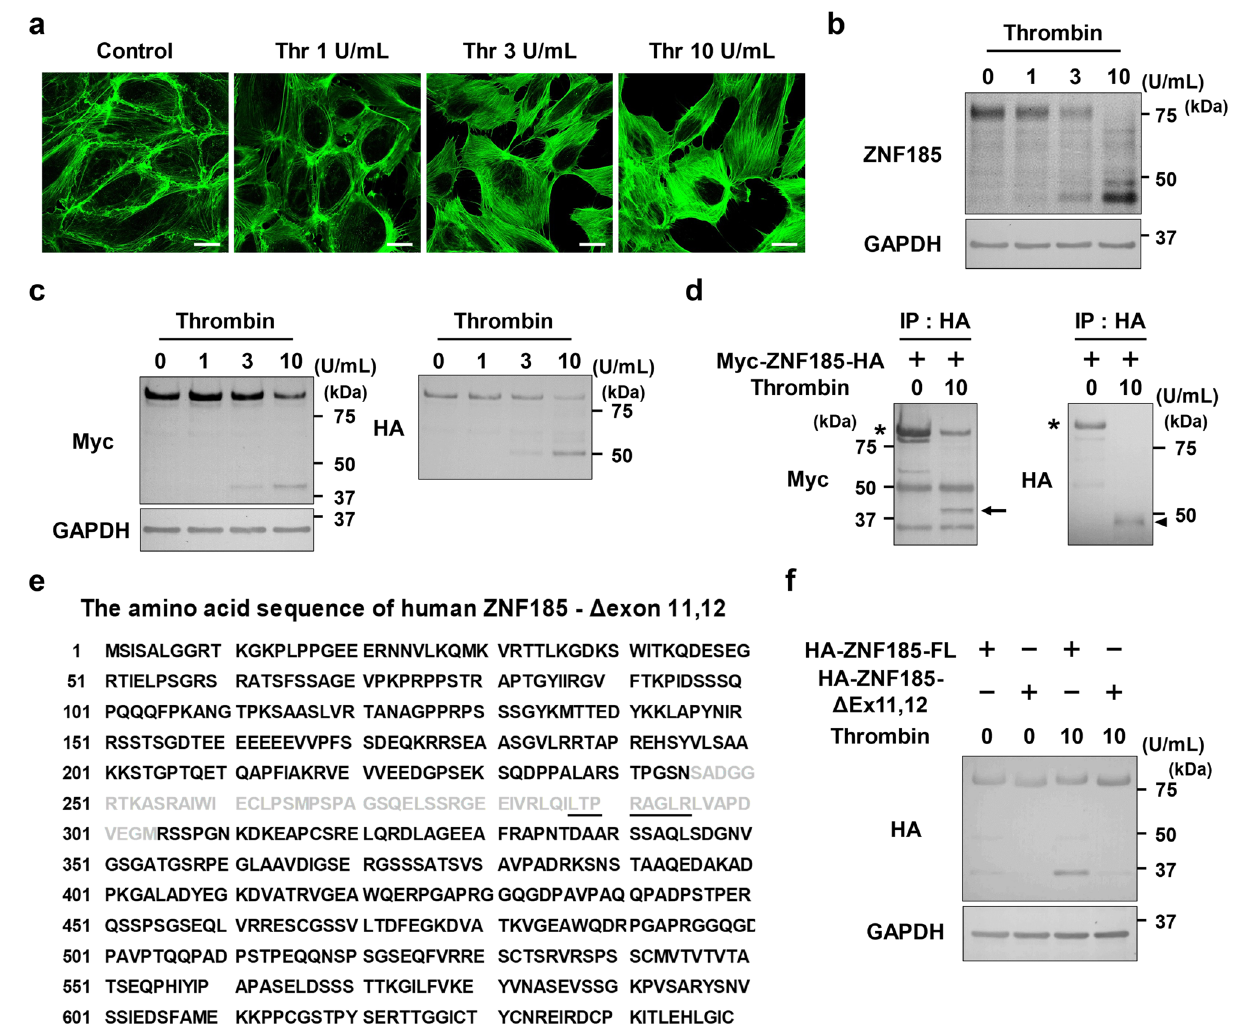
phosphorylation of PKA substrates at the membrane region indicated by white arrows were markedly suppressed by knock- down of plectin or ZNF185 (indicated by white arrowheads) (Supplementary Fig. 12c). ZNF185, plectin, actin, and PKA may form a large complex at the membrane region of endothelial cells, which regulates the balance between stress fi ber formation and endothelial barrier protection, depending on the cAMP/PKA signaling pathway. RhoA inhibition by cAMP/PKA signaling protects against endothelial barrier dysfunction 10,41 . By contrast, both ZNF185 knockdown and thrombin activate RhoA (Fig. 4c) and induce endothelial hyperpermeability (Fig. 4a, b). Not only Y-27632 but also forskolin ameliorates thrombin-induced leaky junctions in endothelial cells. However, in these previous studies, low-dose thrombin <1 U/ml was used 10,42,43 . We demonstrated that high- dose thrombin above 3 U/ml cleaved endogenous Fig. 12a, b). Furthermore,